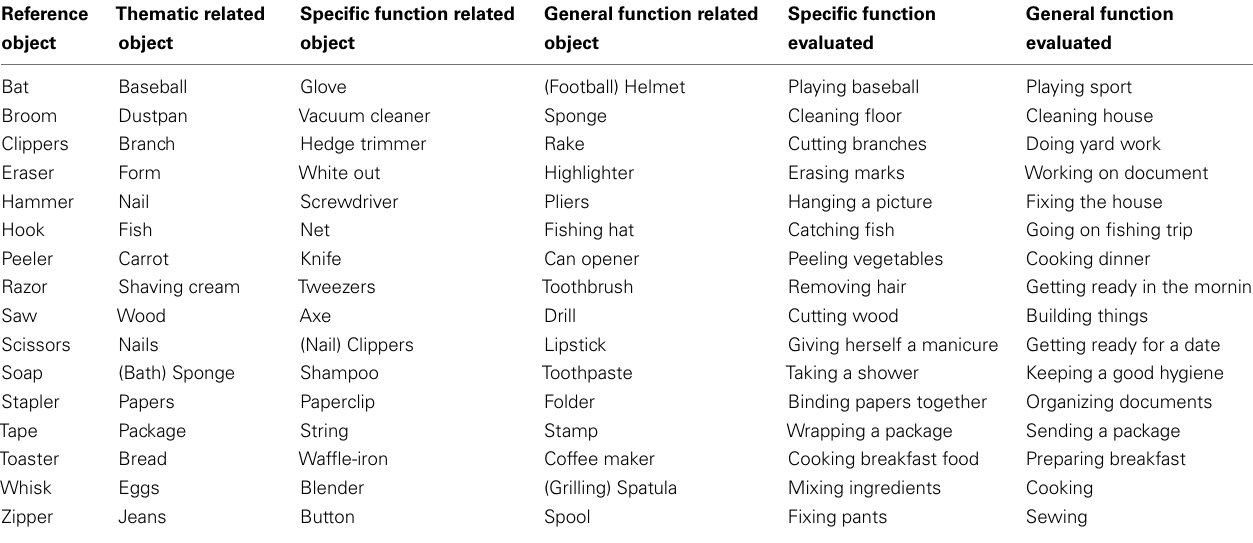
TableA1 | List of critical items in theThematic, Specific Function and General Function conditions, and the corresponding functions evaluated in the